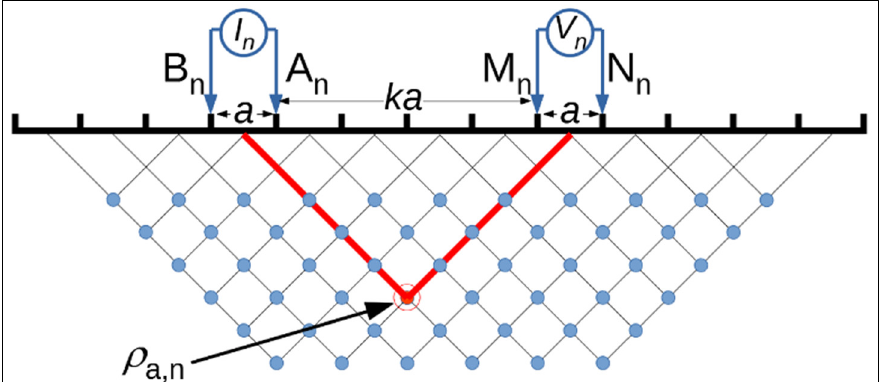
Figure 2. Schematic depiction of the dipole-dipole electrode array.